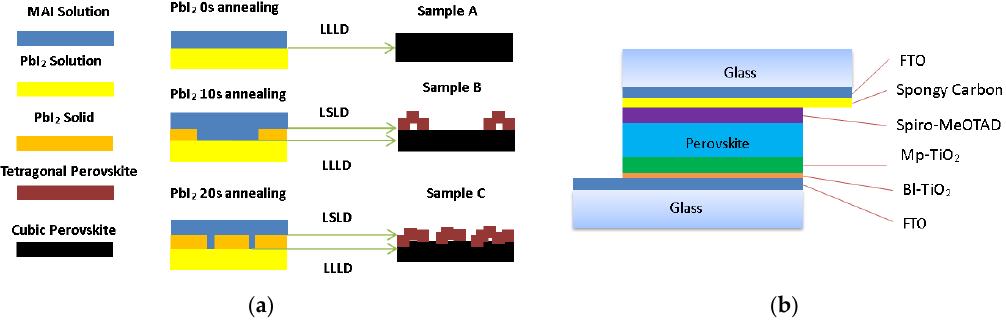
Figure 4. Schematic illustration for diffusion mechanisms and structure of devices: ( a ) Schematic illustration for the mechanisms of LLLD and LSLD for perovskite multi-crystalline film; ( b ) Structure of devices with low-cost spongy carbon/FTO composite counter electrode.